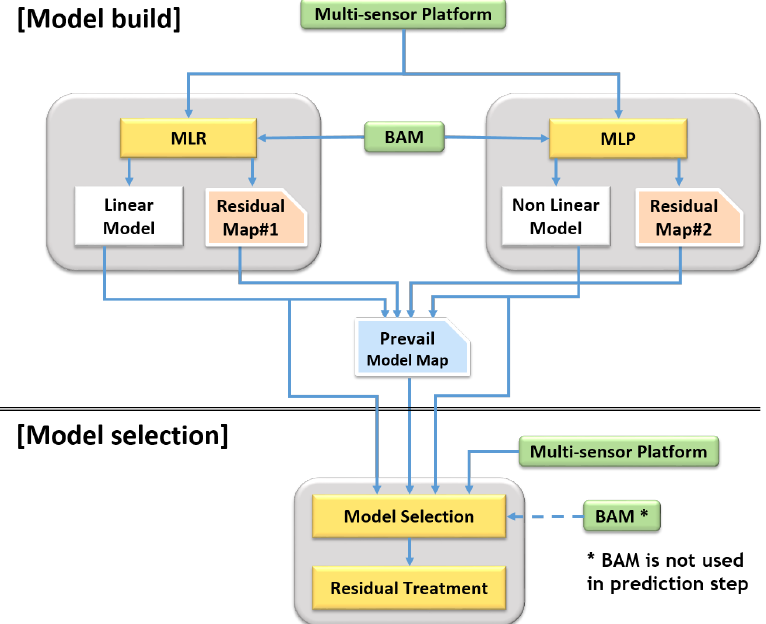
Figure 7. Overall procedures for SMART calibration. (e.g., MLR and multilayer perceptron (MLP) model).